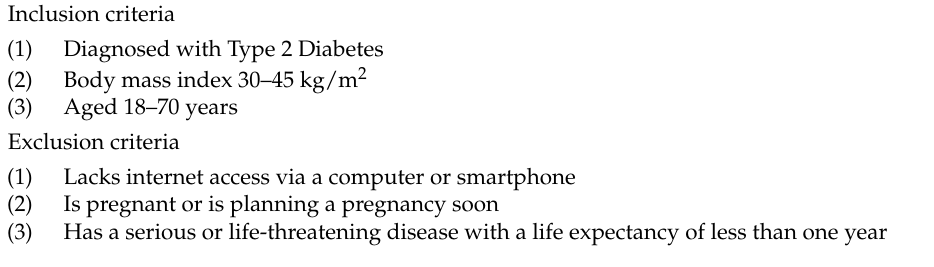
Table 1. Inclusion and exclusion